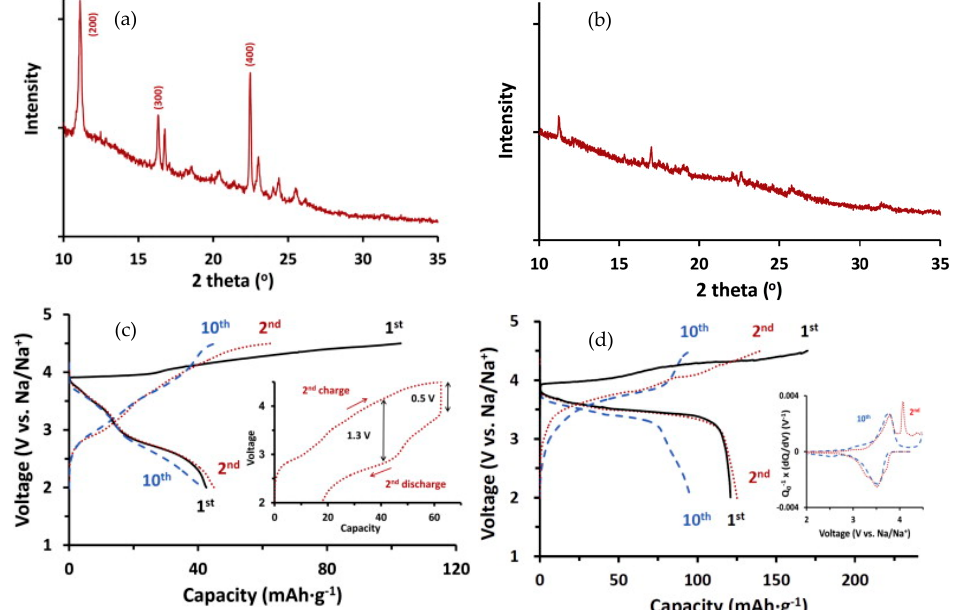
Figure 7. ( a , b ) XRD patterns and ( c ,d) charge and discharge profiles at a current density of 20 mA · g − 1 of crystalline oligopyrene ( a , c ) and amorphous oligopyrene ( b , d ) as candidate cathode materials for sodium-ion batteries; Inset of ( c ) shows the 2nd charge and discharge profile to indicate a large overpotential; Inset of ( d ) shows the differential capacity (dQ/dV) curves for the 2nd and 10th cycles. Adapted from [68], with permission from © 2013 Elsevier .